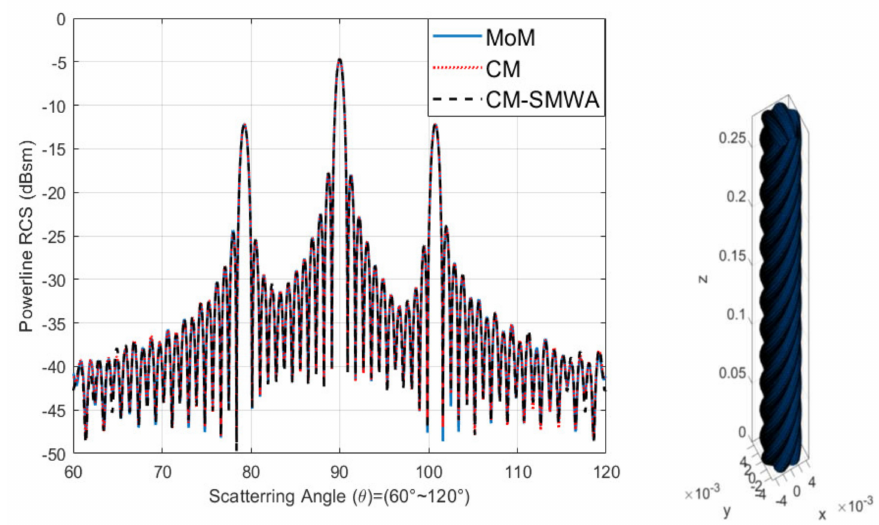
Figure 11. Simulation results of the power line RCS with the different algorithms at 35 GHz (V-V).